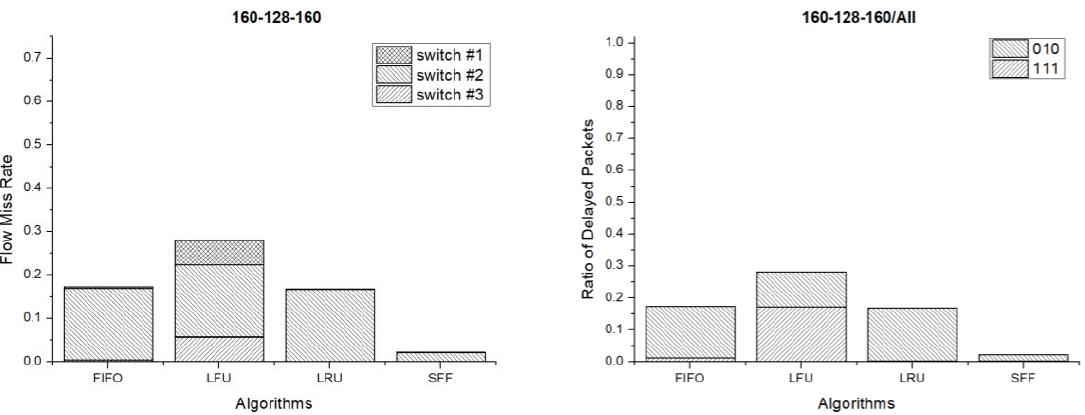
Figure 11. Experiment results with 160-128-160 flow table size.